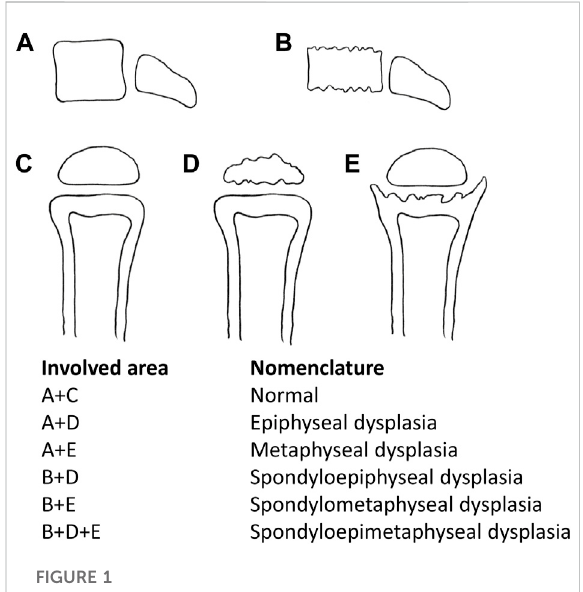
FIGURE 1 Nomenclature according to the involved area name of dysplasia. A + D: epiphyseal dysplasia, A + E: metaphyseal dysplasia, B + D: spondyloepiphyseal dysplasia, B + E: spondylometaphyseal dysplasia, and B + D + E: spondylo- epi-metaphyseal